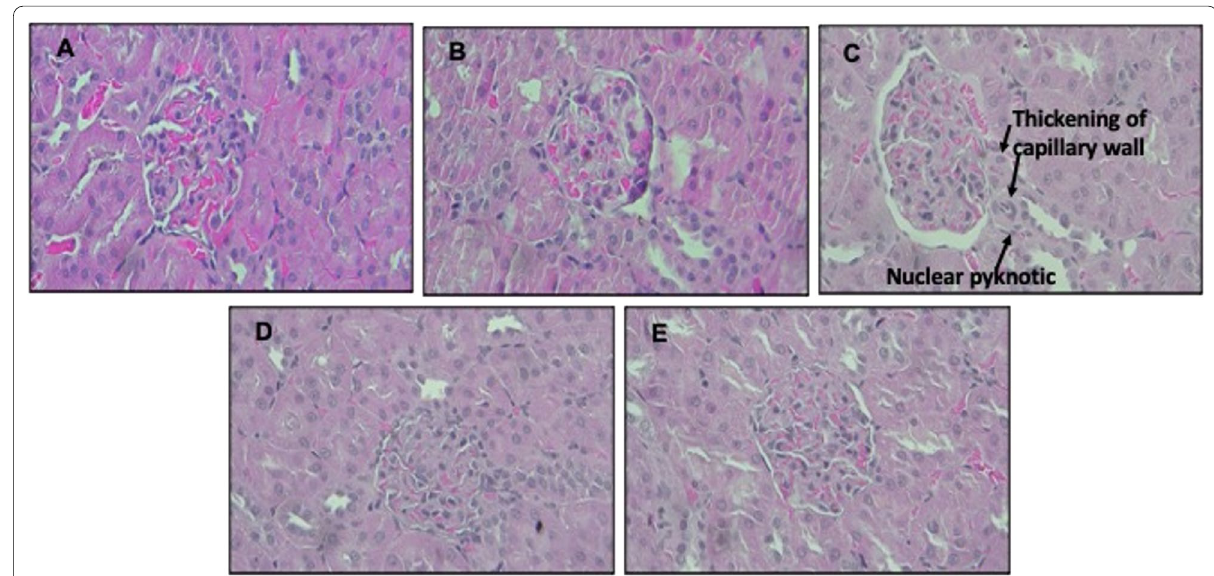
Fig. 4 Effect of AM on HE staining of histological kidney sections. Control and control AM 200 kidney have normal architecture ( A , B ), while + IR group ( C ) showed thickening of capillary wall and nuclear pyknotic (arrows). Alfa-mangostin administration at both doses showed similar architecture to control groups ( D , E ). Magnification ×